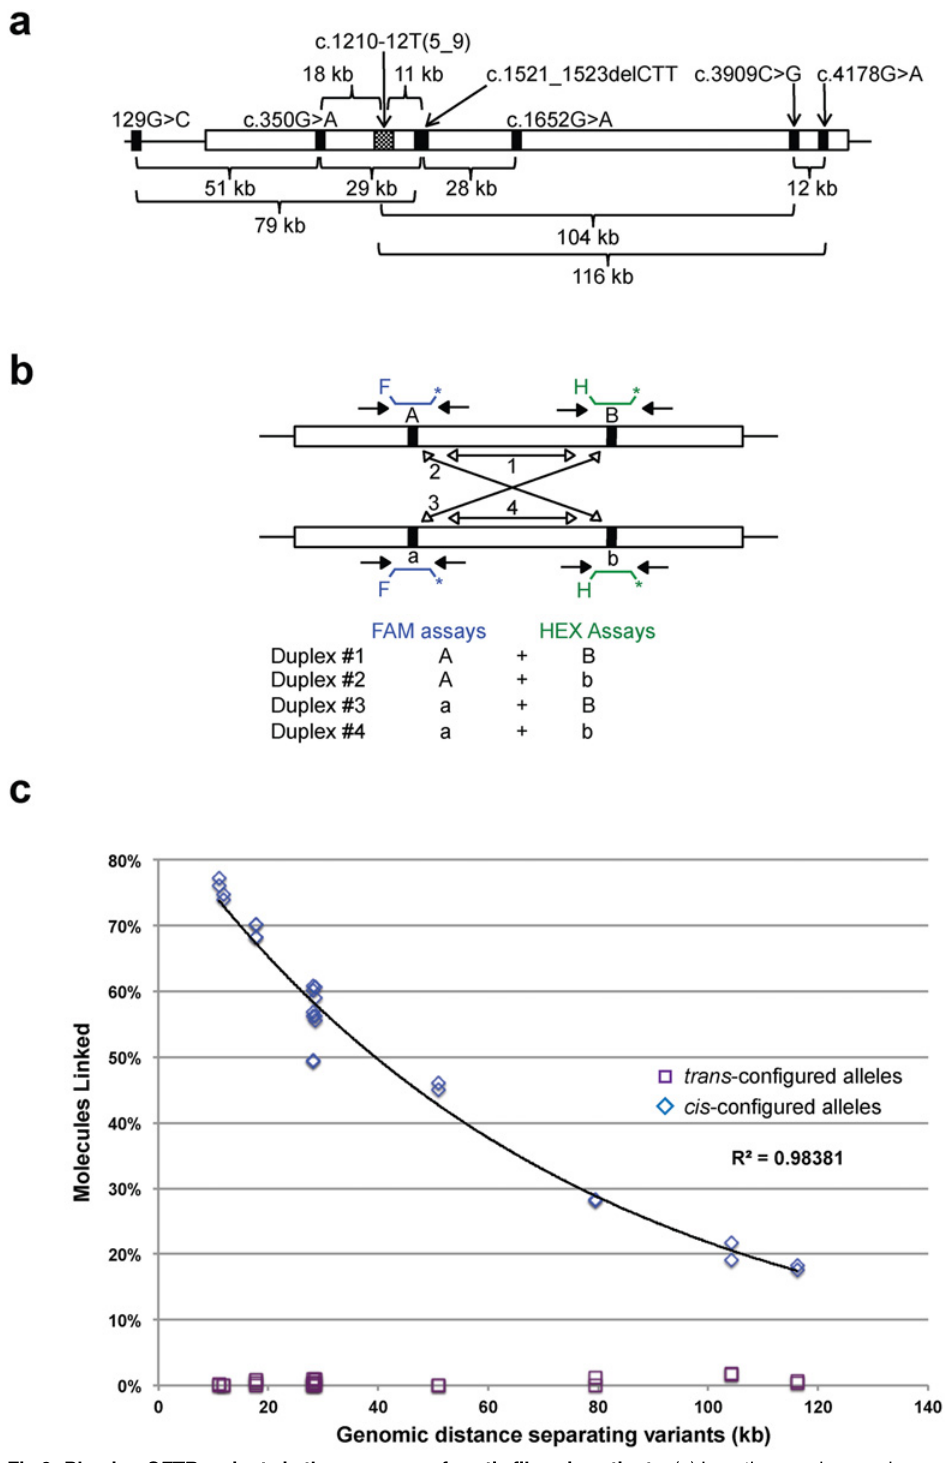
Fig 3. Phasing CFTR variants in the genomes of cystic fibrosis patients. ( a ) Locations and genomic distances separating the variants along the CFTR gene in the tested cell lines. ( b ) Assembly of four duplex assays to redundantly evaluate phase of screened variants. ( c ) Physical linkage of CFTR variants as measured by Drop-Phase, as a function of genomic distance (horizontal axis). Blue diamonds: allele-pairs inferred to be cis -configured; purple squares: allele-pairs inferred to be trans -configured. The black line is